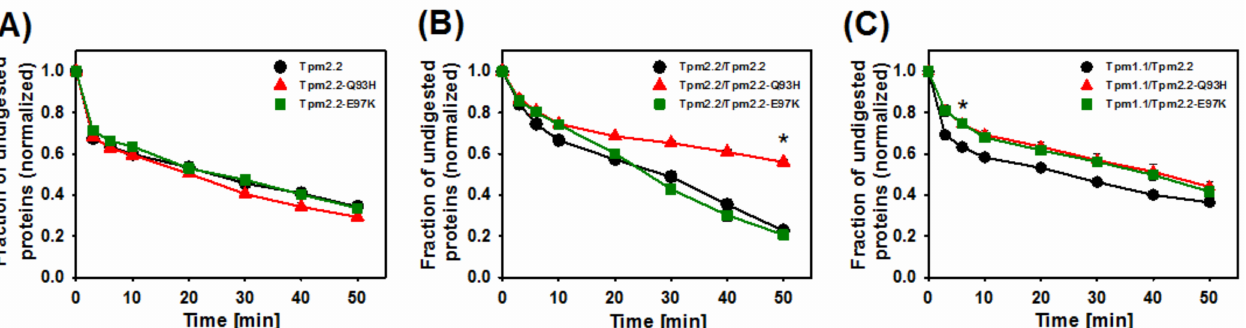
Figure 5. Trypsin digestion rate of tropomyosin homodimers and heterodimers bound to F-actin. Fraction of undigested Tpm2.2 homodimers ( A ), crosslinked Tpm2.2/Tpm2.2 heterodimers ( B ), and crosslinked Tpm1.1/2.2 heterodimers ( C ) circles), Q93H mutation (red triangles), and E97K mutation (green squares). Data represent the mean ± SE ( n = 3–5).